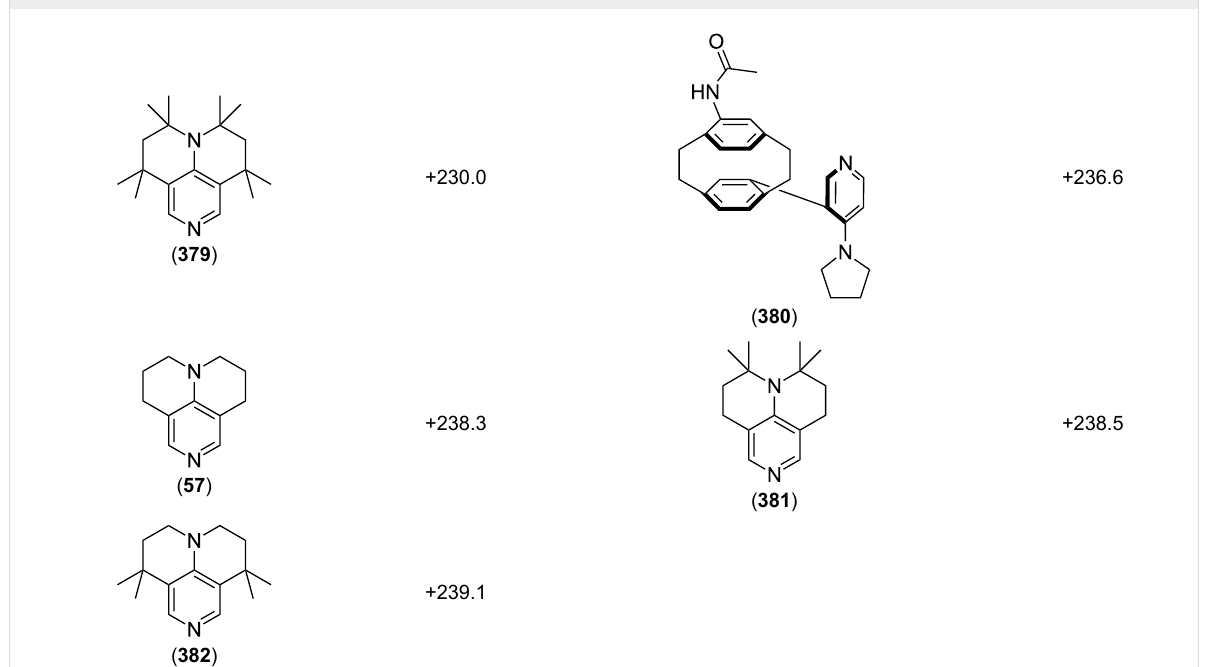
Table 13: ACA values of pyridines and 4-aminopyridines, ordered by increasing ACA values. (continued)